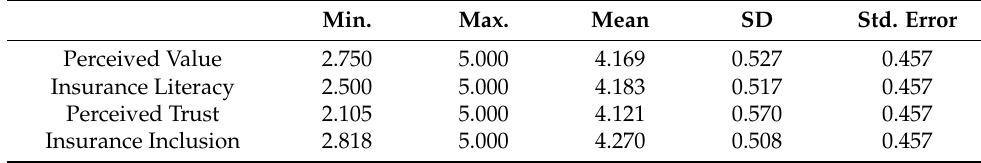
Table 7. Descriptive statistics.